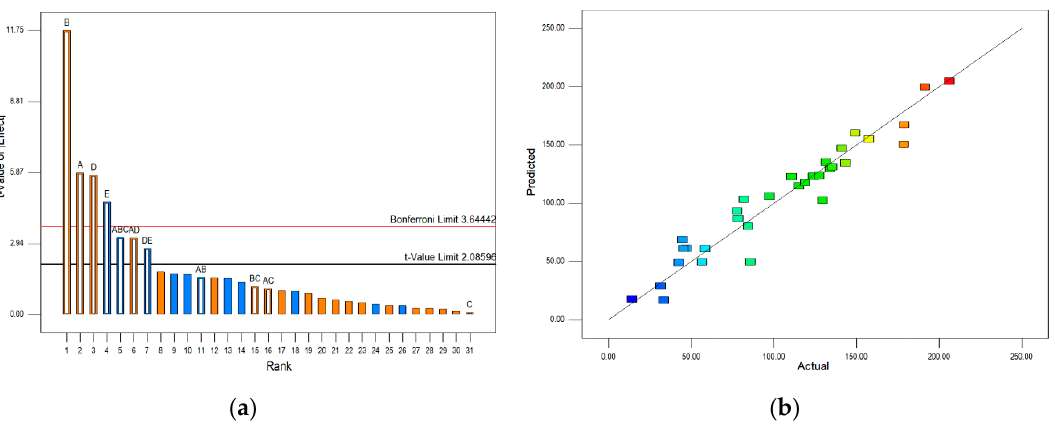
Figure 4. Total phenolic acid content model: ( a ) Pareto chart; ( b ) actual vs. predicted results. Independent variables: A = glycerol concentration; B = temperature; C = ultrasound power; D = time; E = ascorbic acid concentration. Blue color on the chart ( a ) indicates a negative and the orange color refers to a positive effect of independent variables. The color points on the chart ( b ) represent the value of total phenolic acid (blue: lowest value; red: highest value).